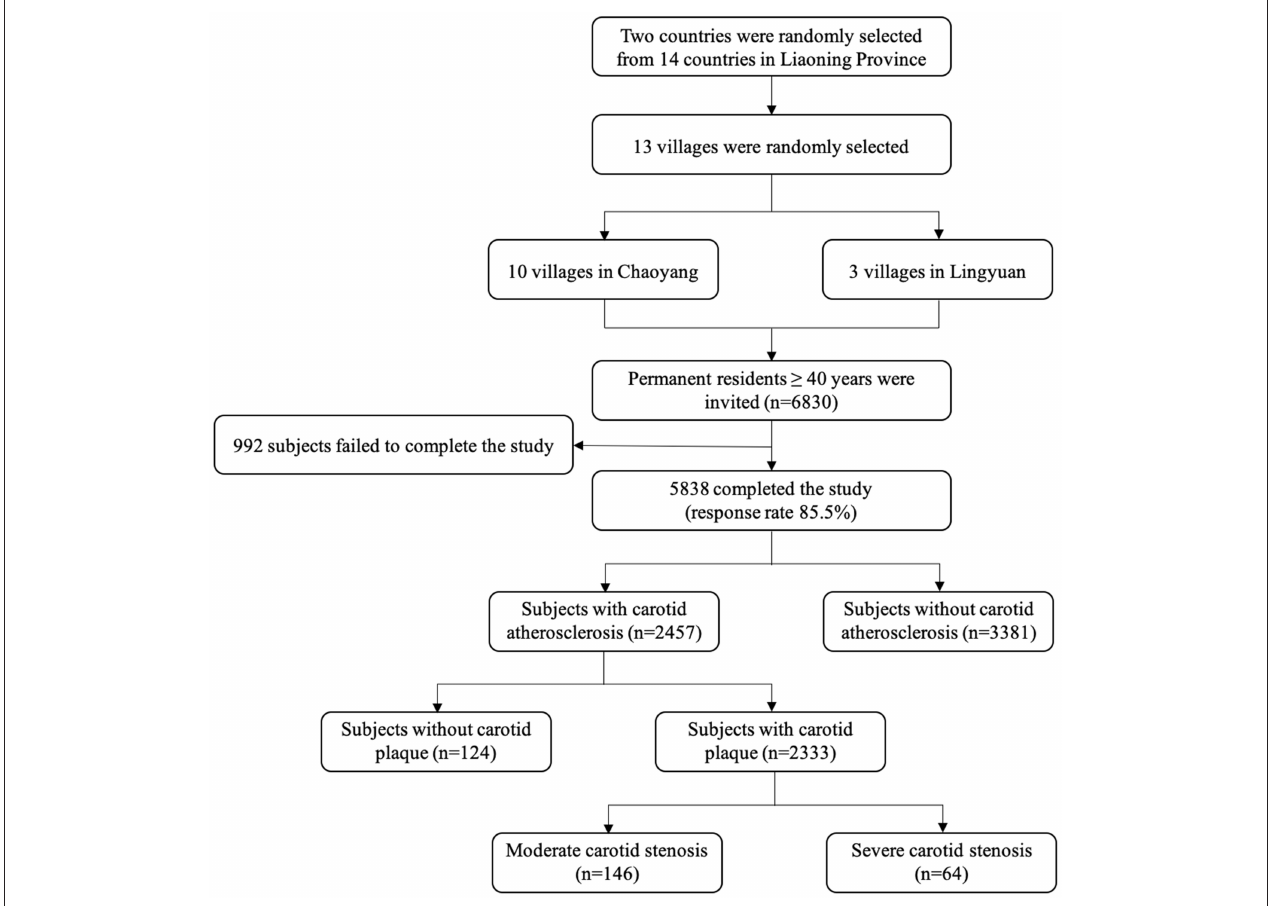
FIGURE 1 | Flow chart of population